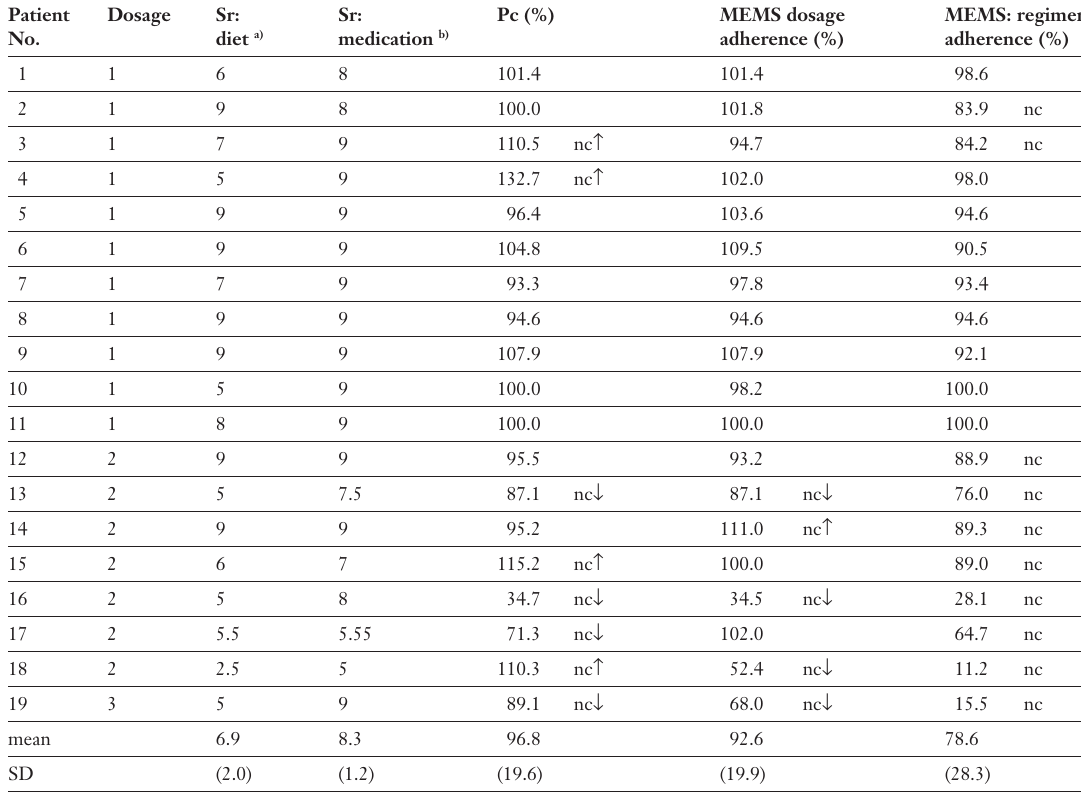
Individual adherence assessments (Sr = Self report; Pc = Pill count; MEMS = Medication Event Monitoring